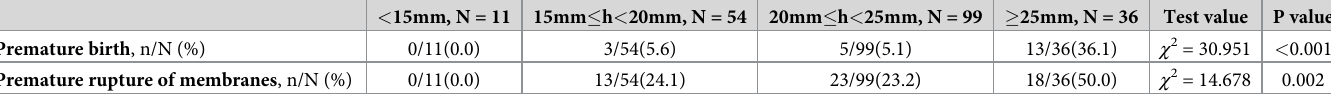
Table 4. The impact of cone heights on preterm delivery and premature rupture of membranes.